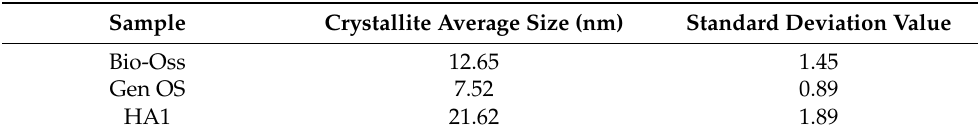
Table 1. Crystallite average size for HA1, Gen-Os, and Bio-Oss by Rietveld